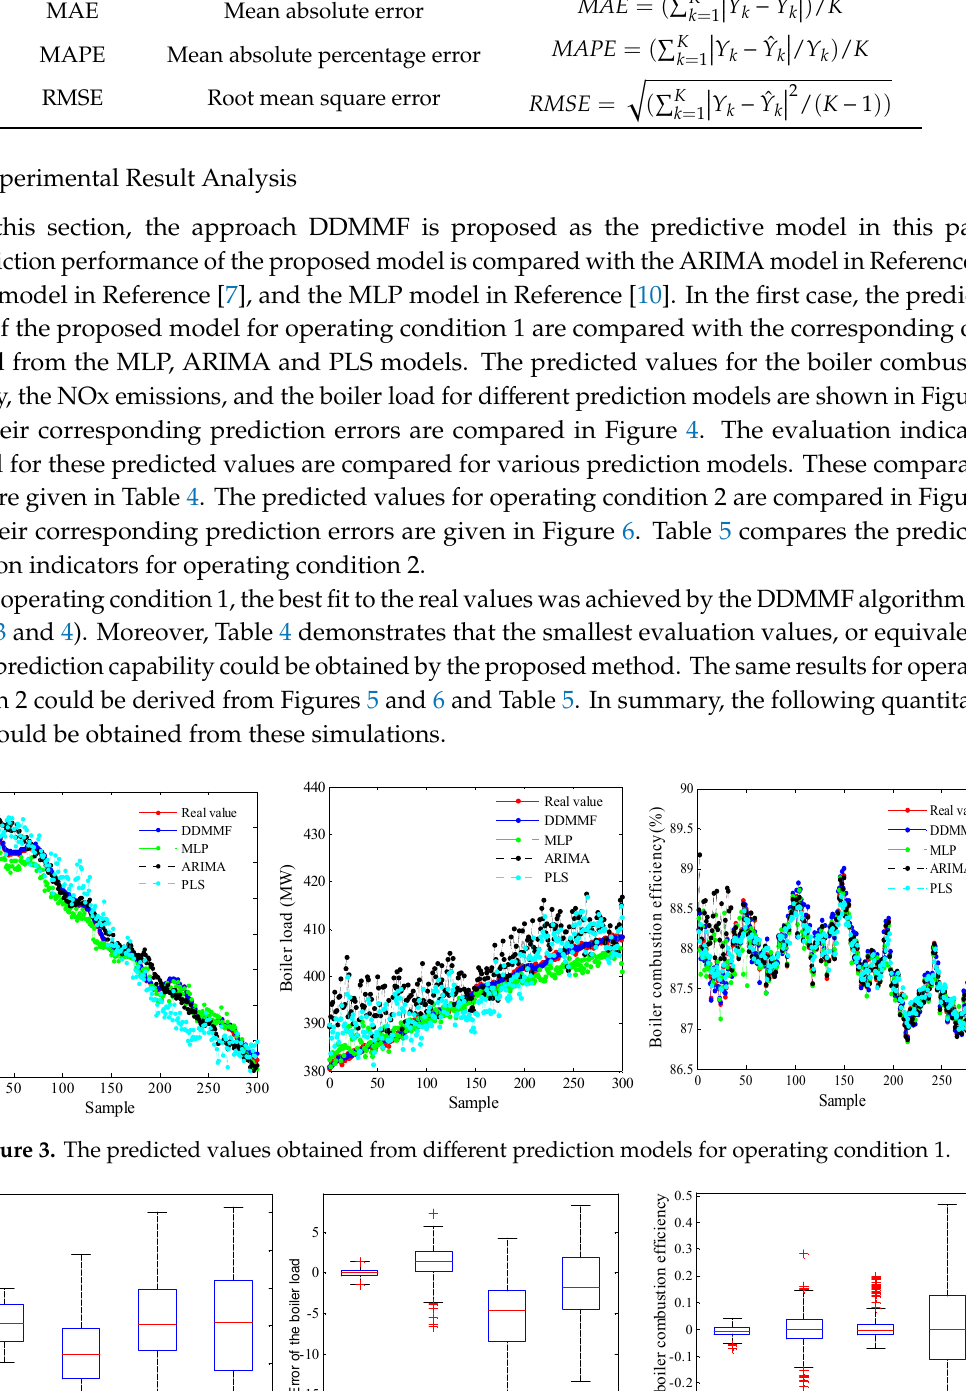
2.8 × 10 −4 Figure5. The predicted values obtained from different prediction models for operating condition 2.